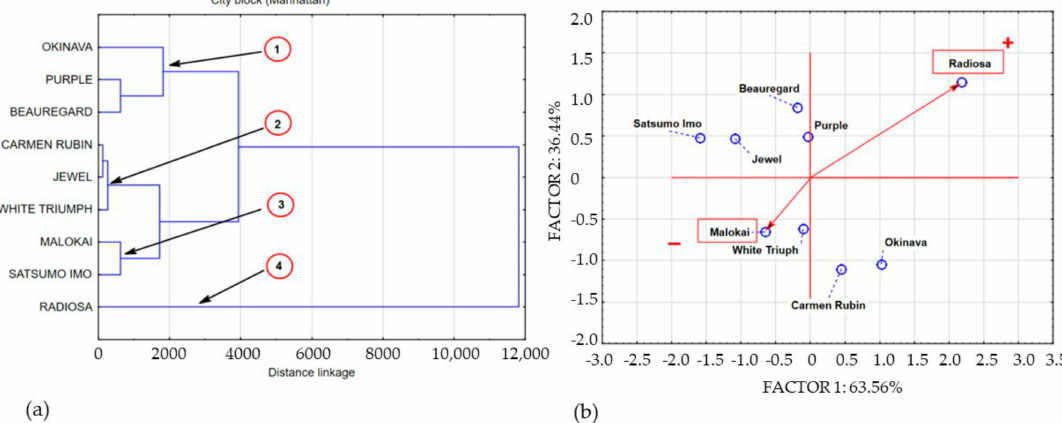
Figure 3. Dendrogram and bio-plot (PCA) of average concentrations of polyphenols in sweet potato leaves collected in BBCH phase 51. ( a ) 1,2,3,4 clusters. ( b ) + variety with the highest concentration polyphenolics compounds, − variety with the lowest concentration polyphenolics